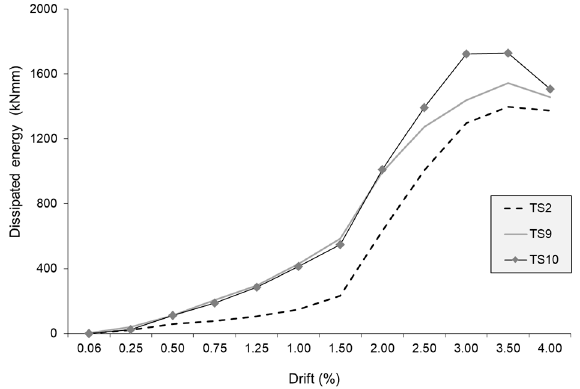
Figure 14. Mean dissipated energy per load cycle as function of drift.